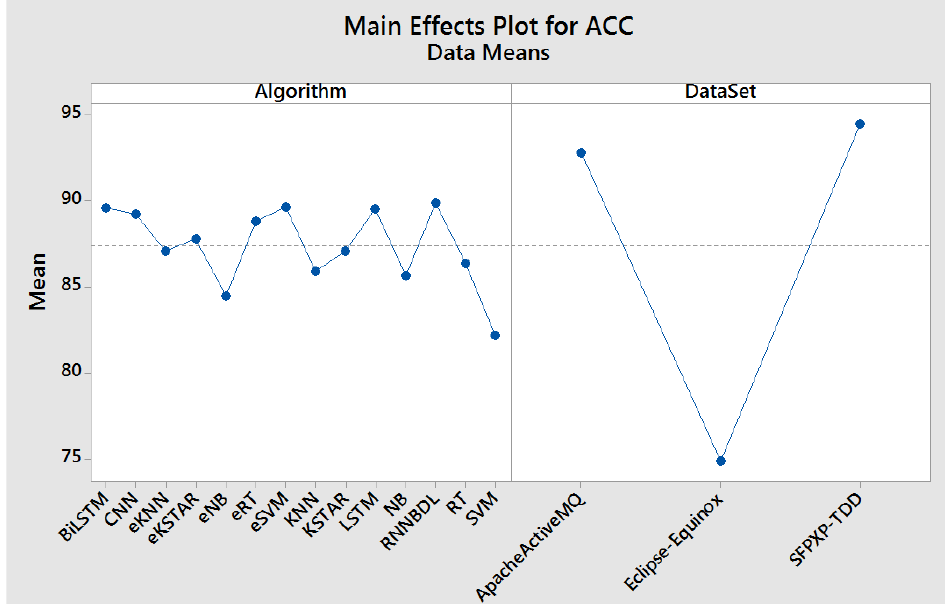
Figure 5. The main effects plot for accuracy based on the methods and the main effects plot for accuracy based on the data sets.